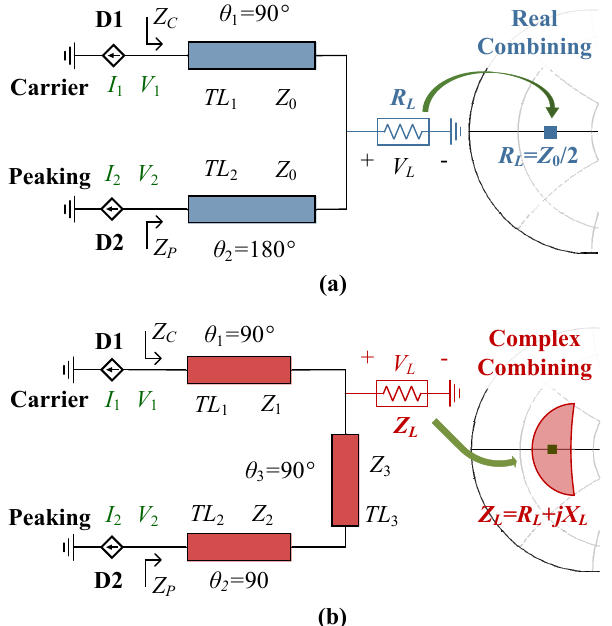
Figure 1. Simplified block diagrams of ( a ) the traditional DPA and ( b ) the proposed